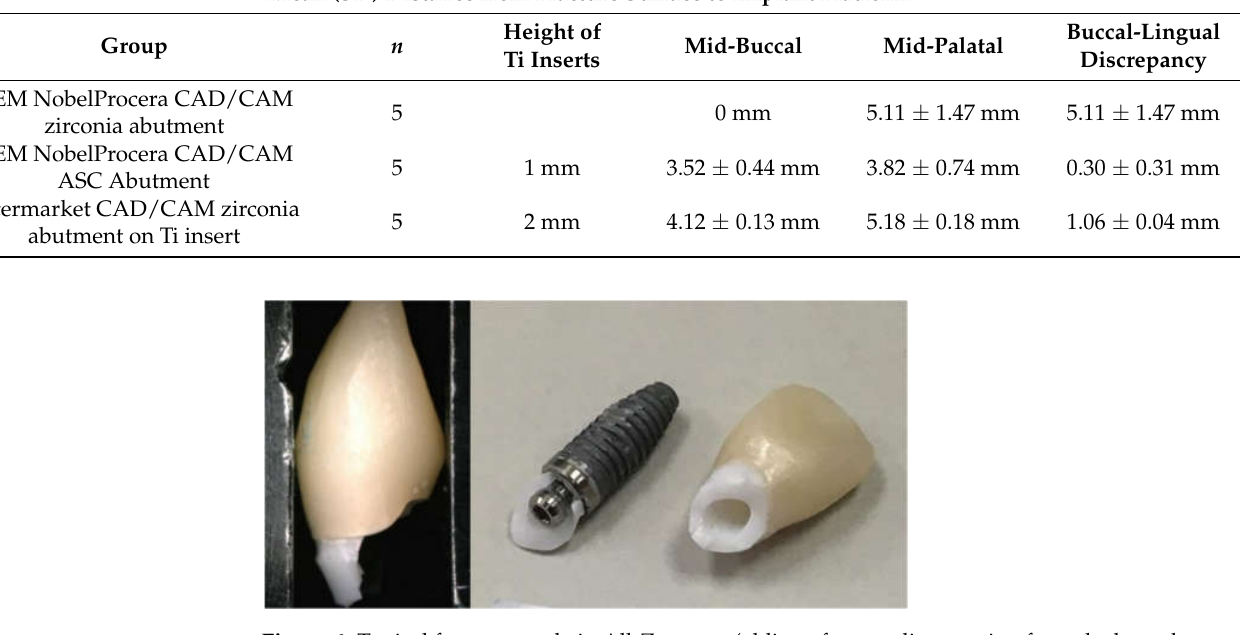
Figure 6. Typical fracture mode in All-Zr group (oblique fracture line starting from the buccal aspect in the internal hexagon region).